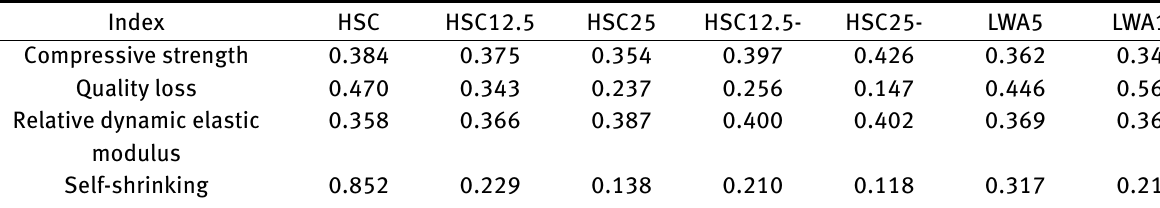
Table 6: Evaluation value of each test group Group HSC HSC12.5